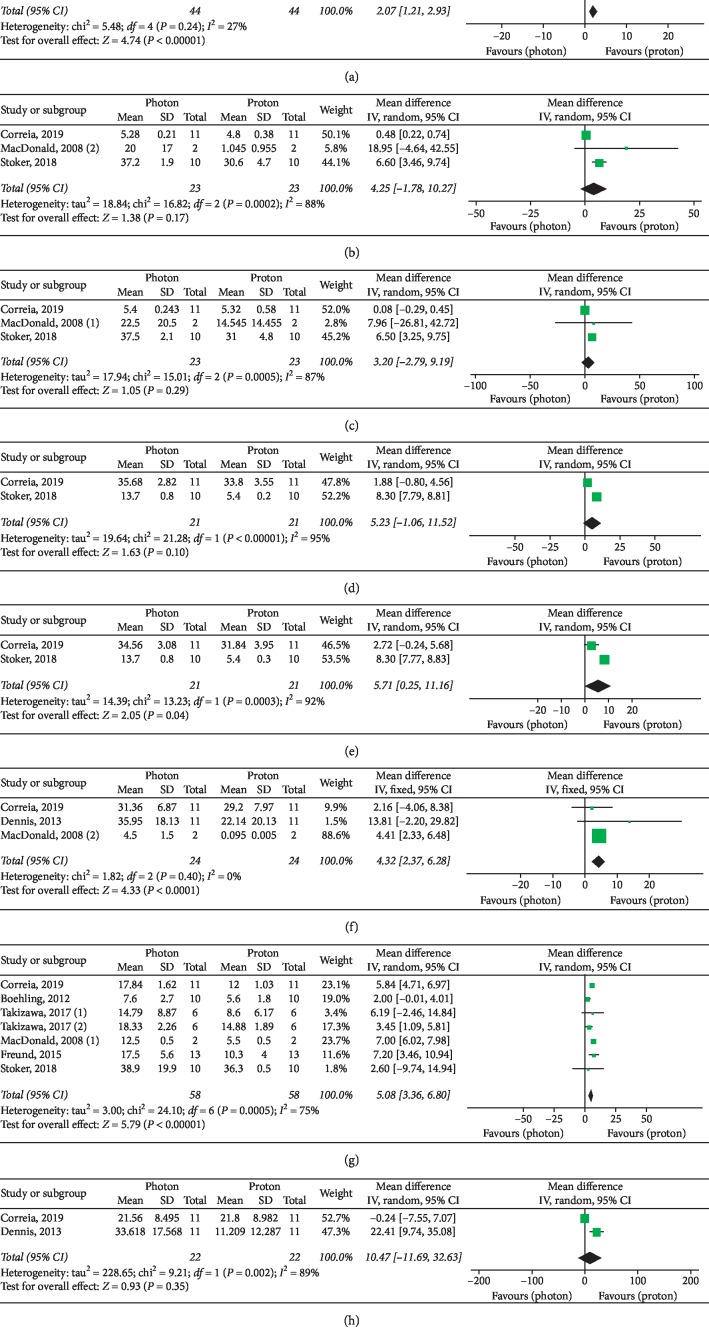
Dmean of intracranial OARs. (a) Brainstem. (b) Left cochlea. (c) Right cochlea. (d) Left hippocampus. (e) Right hippocampus. (f) Optic chiasm. (g) Normal brain. (h) Pituitary gland. When not otherwise specified, the photon RT technique is IMRT or VMAT. Takizawa, 2017 (1): patients affected by ependymoma (IMRT versus PBT); Takizawa, 2017 (2): patients affected by germinoma (IMRT versus PBT); MacDonald, 2008 (1): proton technique: IMPT; MacDonald, 2008 (2): proton technique: 3D conformal PBT.